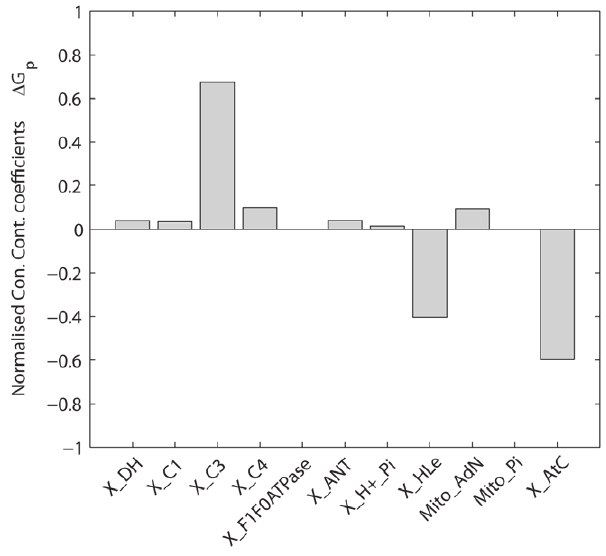
Figure 2. Normalized concentration control coefficients for cellular phosphate potential ( n G p ). Concentration control coeffi- cients were calculated for cellular ATPase rate 0.01 mM/s.